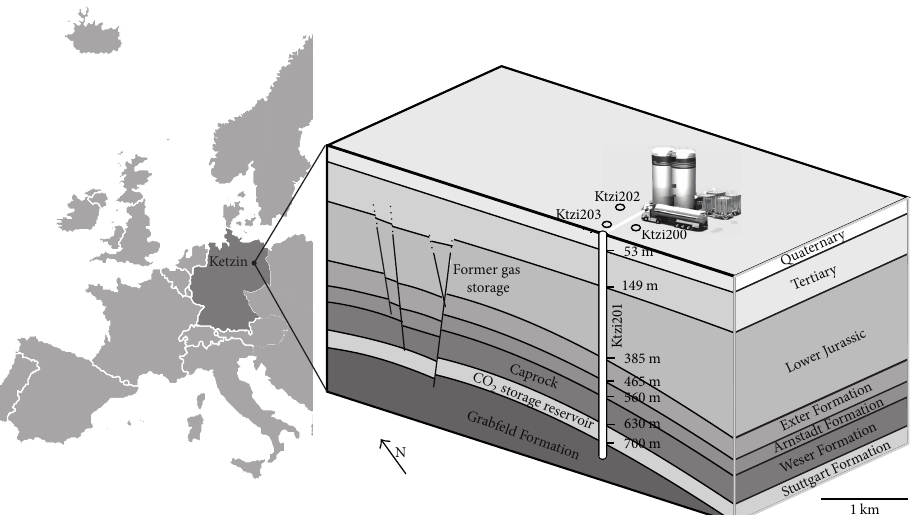
Figure 1: Location and structure of the Ketzin storage site. Left: Ketzin is located in the Federal State of Brandenburg (Germany) about 35 km west of Berlin. The Ketzin site is marked as a dot. Right: schematic and vertically exaggerated block diagram of the Ketzin storage site (not to scale, modified after Liebscher et al. [27]) illustrating the structure and stratigraphy of the Ketzin anticline. The target CO 2 storage zone in the upper part of the Stuttgart Formation covers the range of 630 m–650 m below ground level.